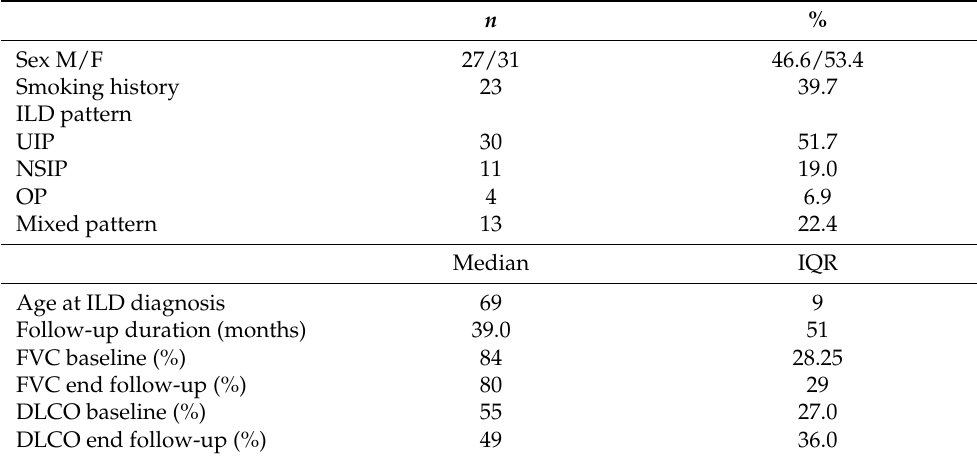
Table 1. Baseline features of 58 anti-MPO-ILD